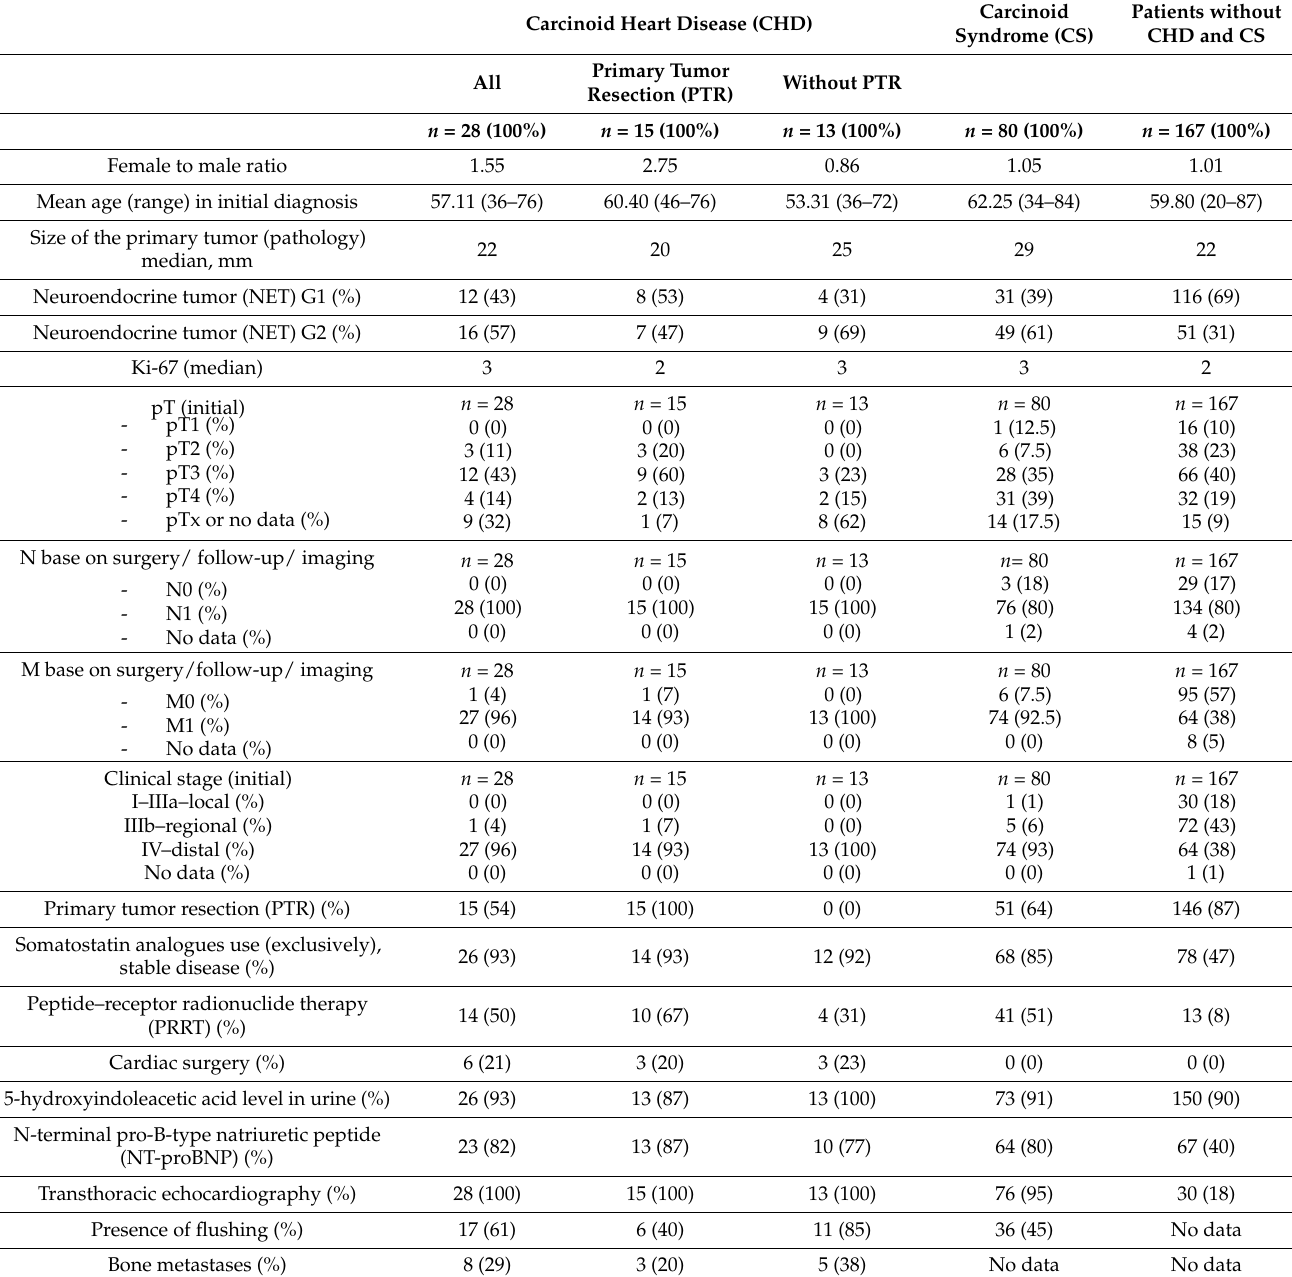
Table 2. Patients and tumor characteristics in neuroendocrine neoplasms of the small intestine. Carcinoid Heart Disease